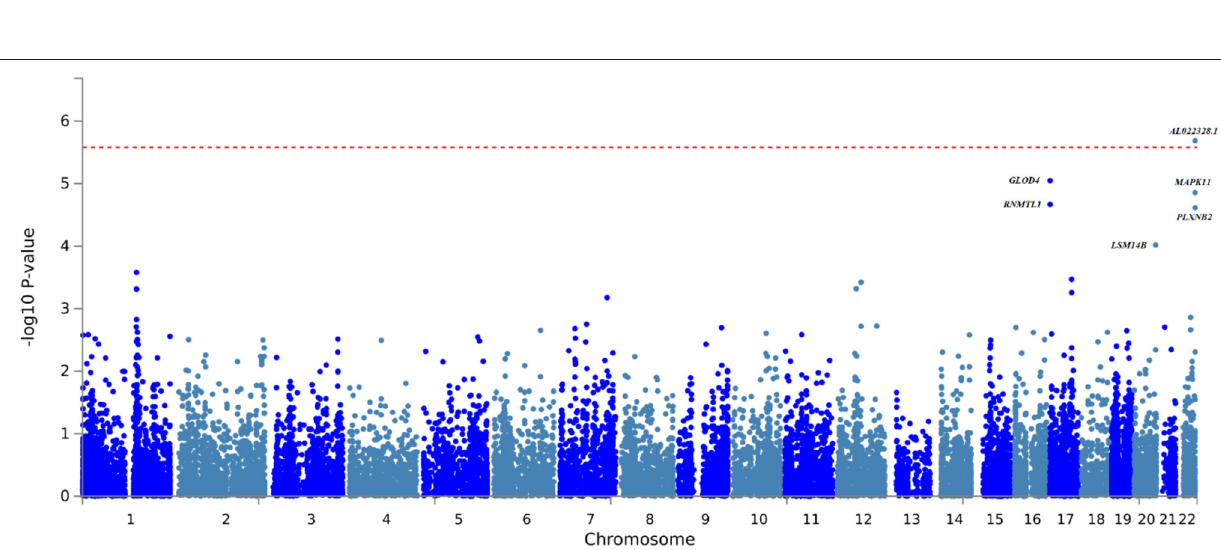
Frontiers in Neurology |